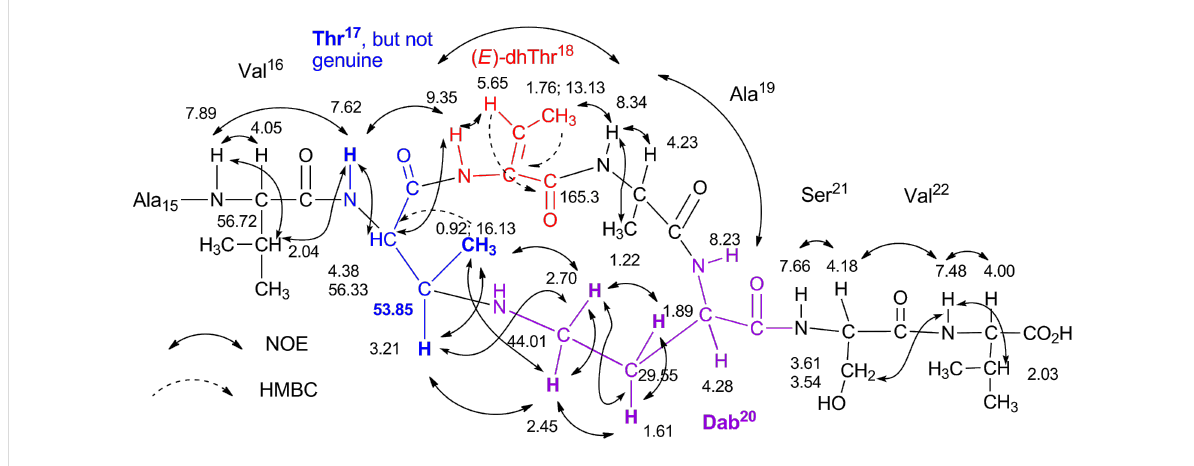
Figure 9: Partial structure of compound B (Val 16 to Val 22 residues). The chemical shifts ( δ H and δ C (ppm)) are shown, and these values were ob- tained in DMSO- d 6 (600 MHz NMR instrument).